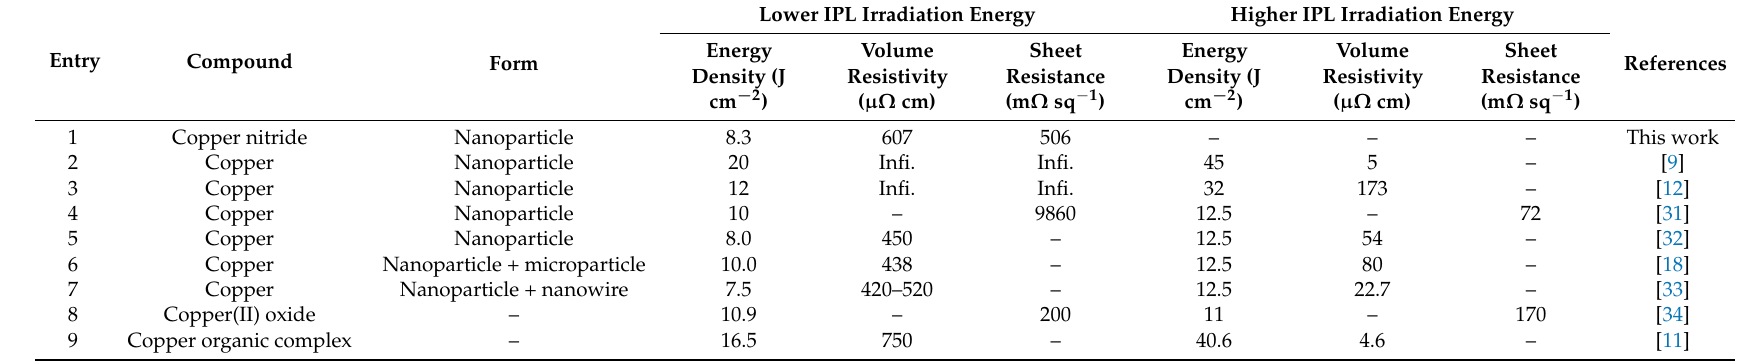
Table 6. Comparison of compound information and obtained values of resistance described in the present study with previously reported